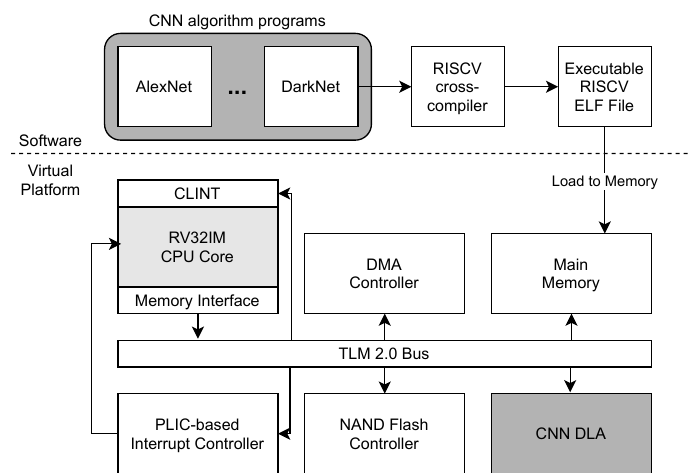
Figure 1. Architecture Overview of RISC-V Virtual Platform with CNN Deep Learning Accelerator.